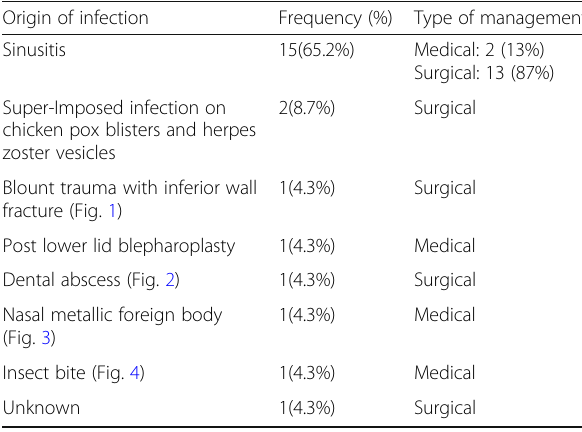
Table 2 Summary of the predisposing causes of non-medial orbital